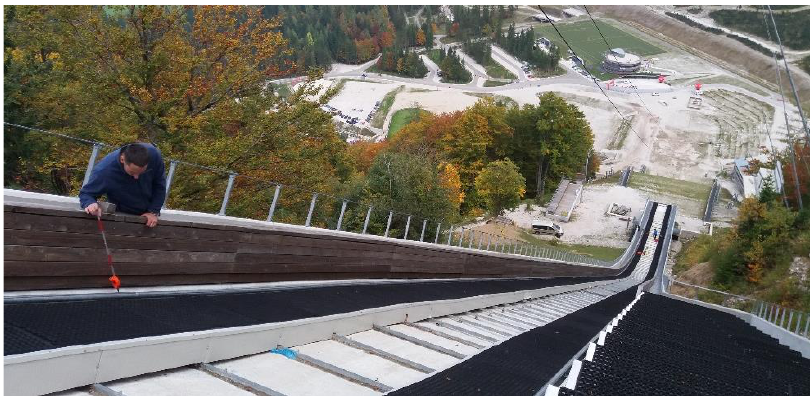
Figure 10. Measurements with the single-prism method on the inrun of Planica ski-flying hill.